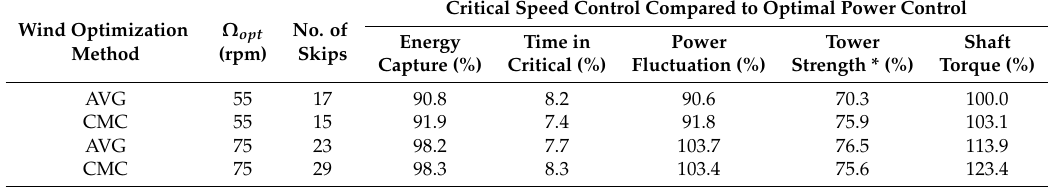
Table 4. Simulation results of the critical speed controller based on the 60-min time series. In each case, the performance is compared to an optimal torque simulation without a critical speed.